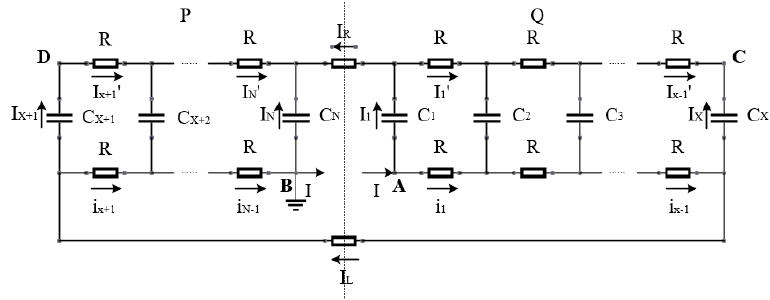
Figure 3. Network model of stator and rotor without common grounding point.